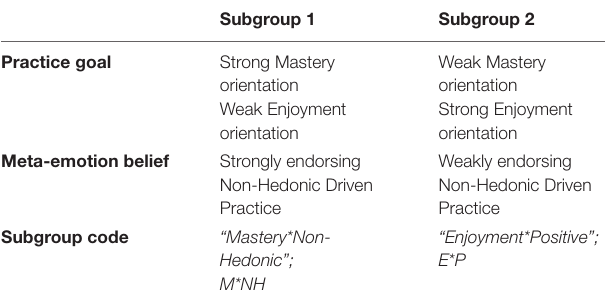
TABLE 5 | Criteria for subgroup